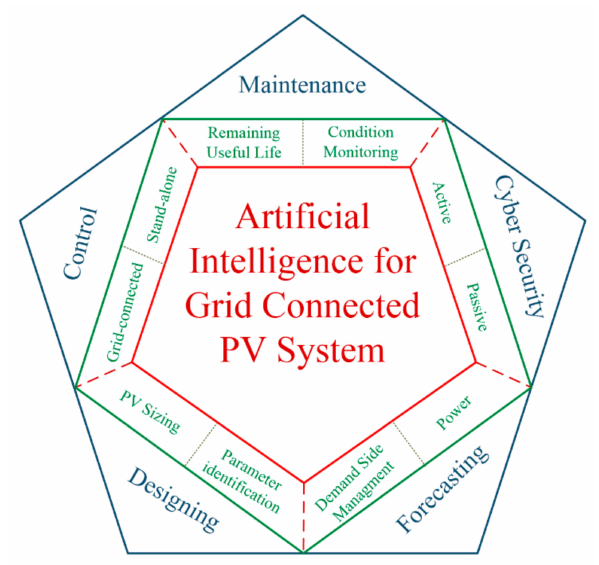
Figure 1. Application of artificial intelligence for power system.